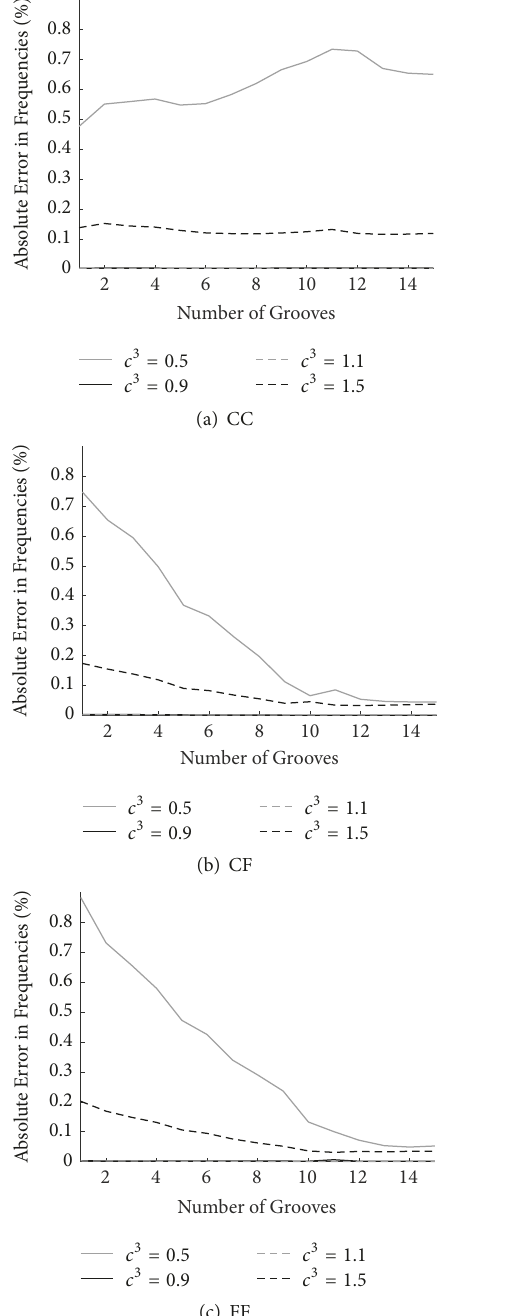
Figure 15: Frequency errors for variable groove number and norm minimization of difference.